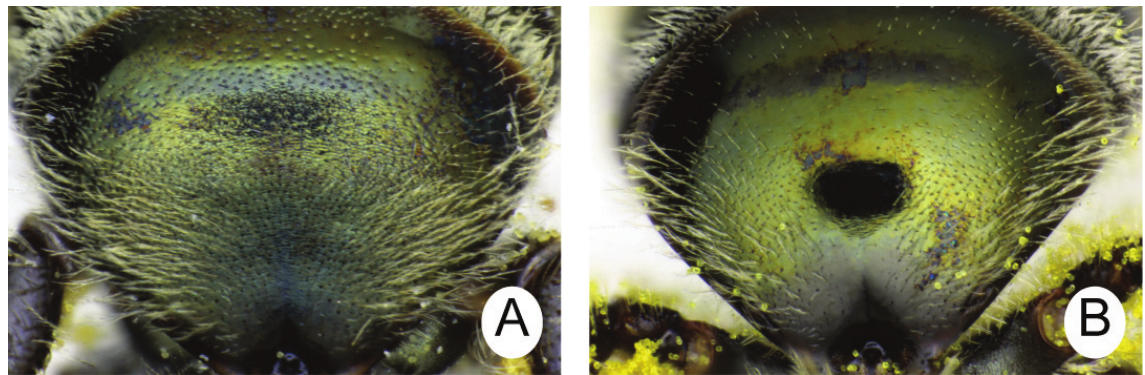
Fig. 25. Photographs for keys: T1 of female. A . Lasioglossum ( Dialictus ) viridellum (cockerell, 1931). B . L . ( D .) pseudannulipes (Blüthgen, 1925).